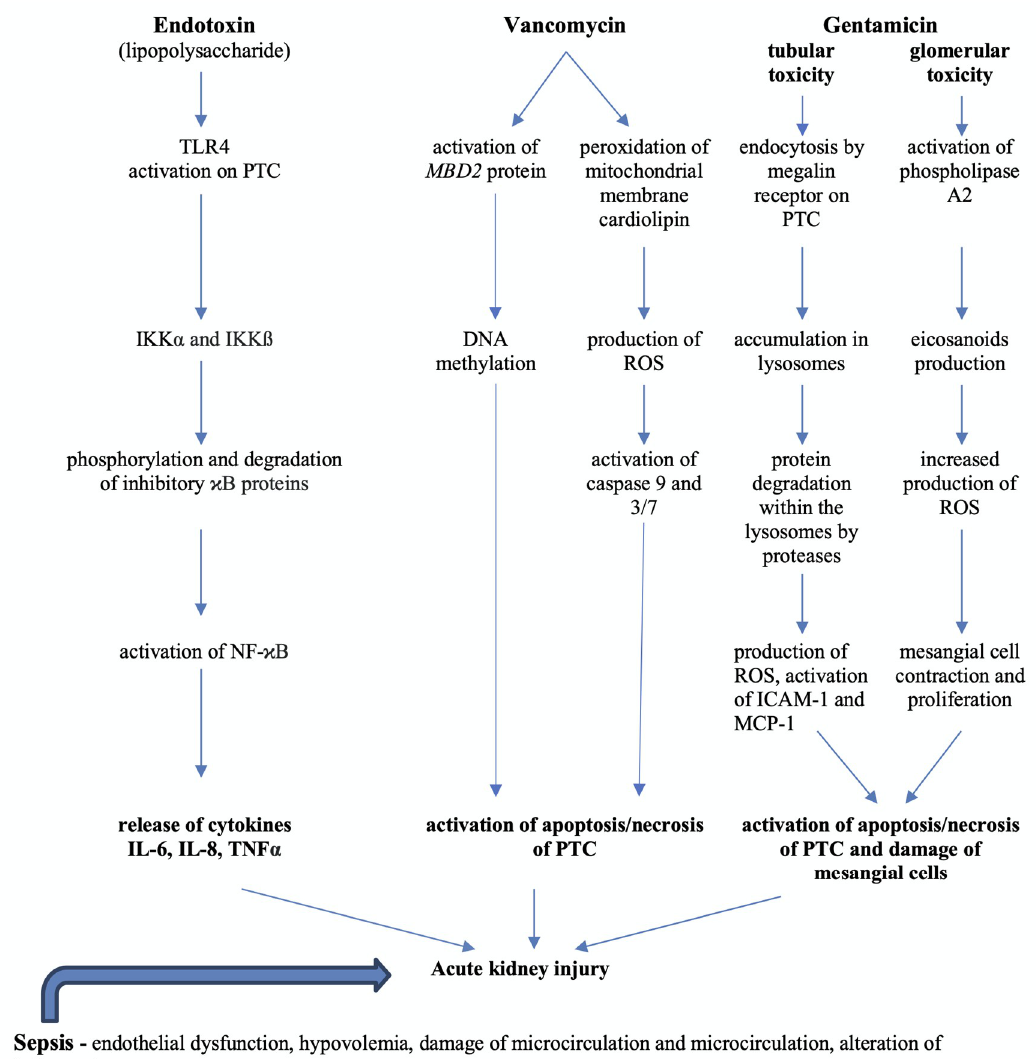
Figure 1. Simplified pathophysiology of acute kidney injury development in sepsis and selected antibiotic treatment [6,10,42,47,48,51,55,56]. DNA—deoxyribonucleic acid ,